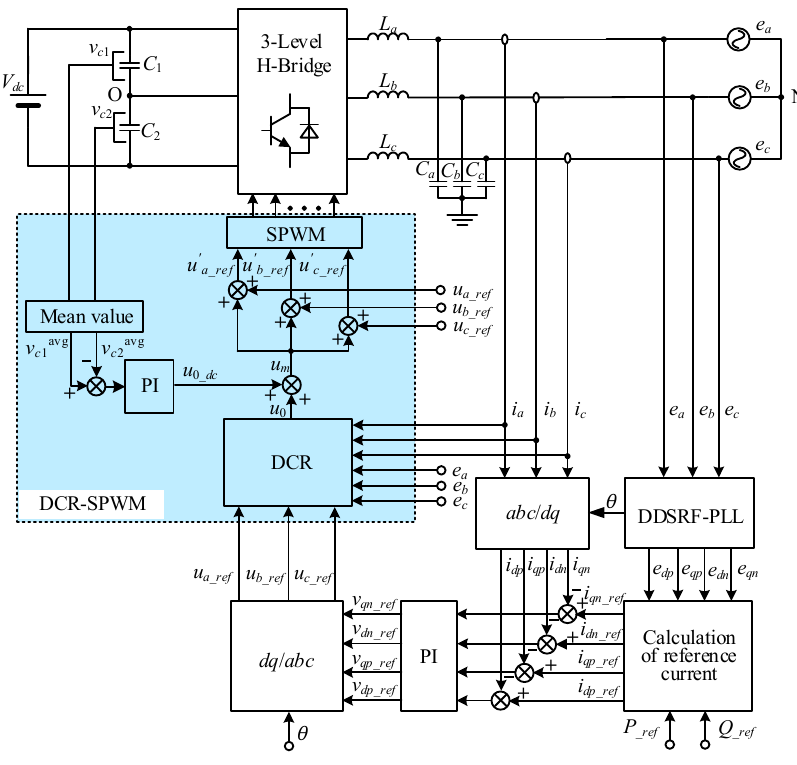
Figure 5. Control principle diagram of the NPC three-level grid-connected inverter.